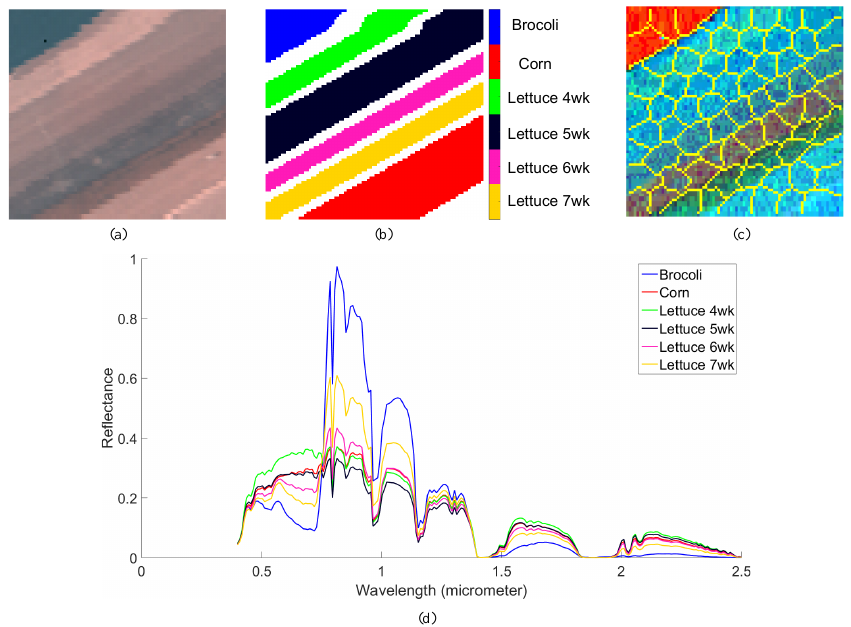
Figure 10. ( a ) The original RGB image. ( b ) The corresponding ground truth materials of Salinas-A dataset. ( c ) The superpixel map we used for the experiment. ( d ) The mean spectra of the 6 materials.